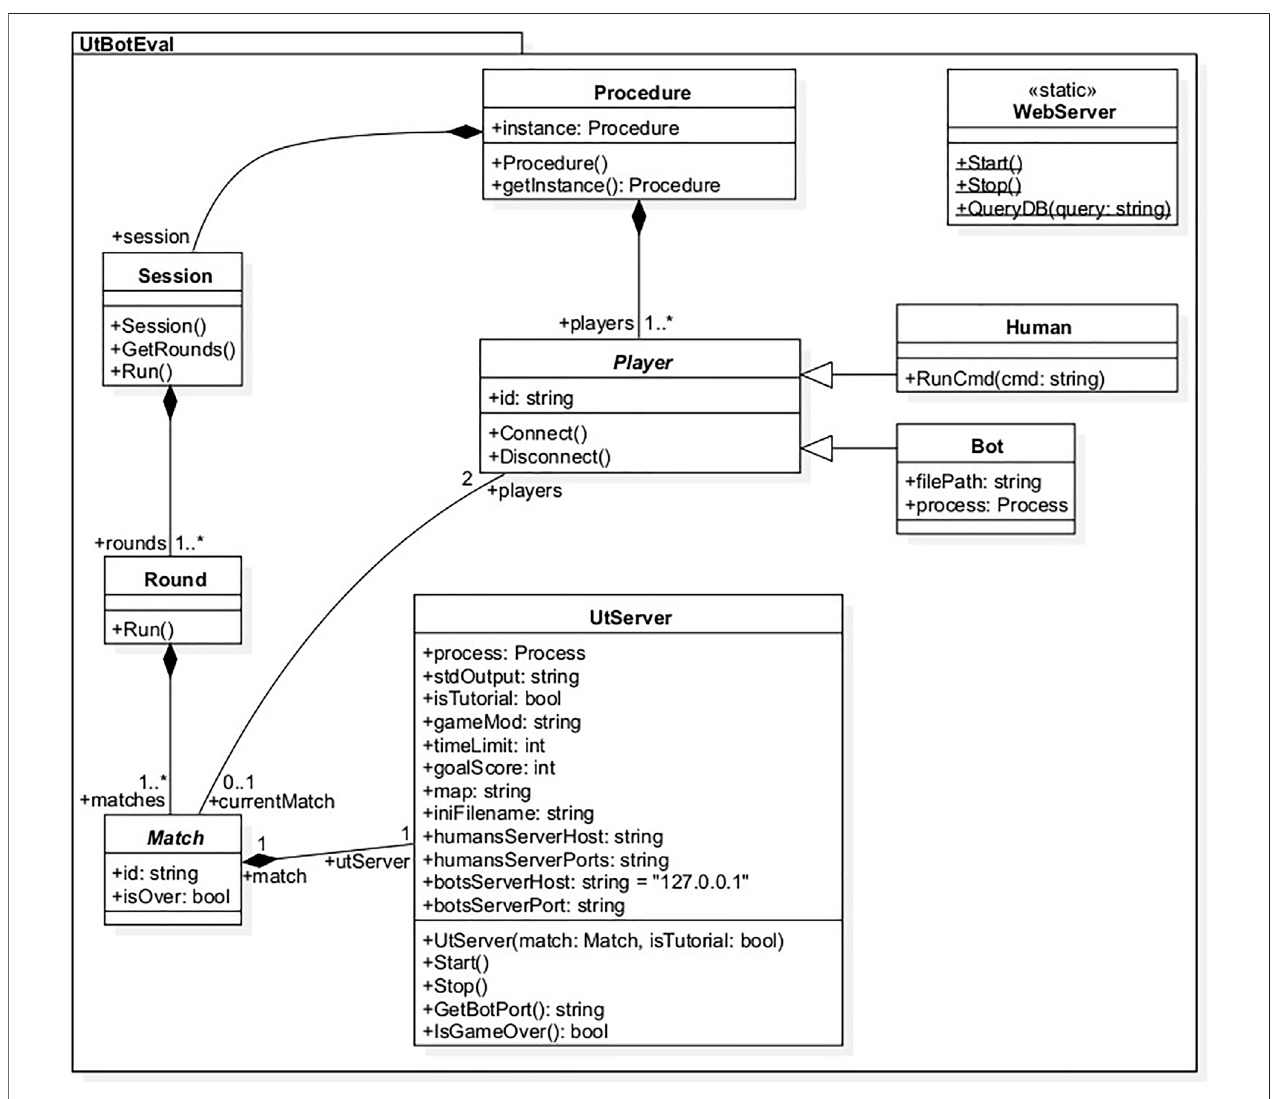
FIGURE 2 | UML class diagram of the UtBotEval